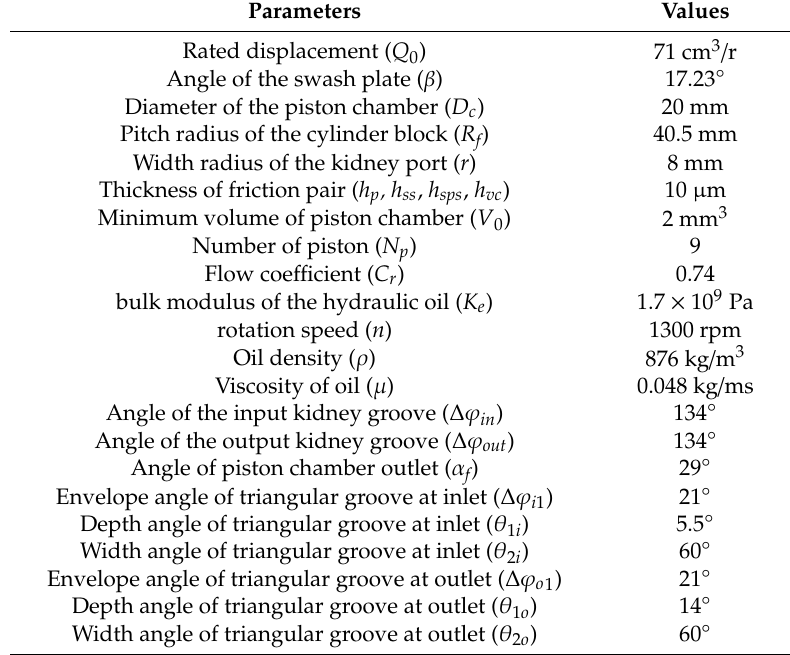
Table 2. Parameters of the pump model.